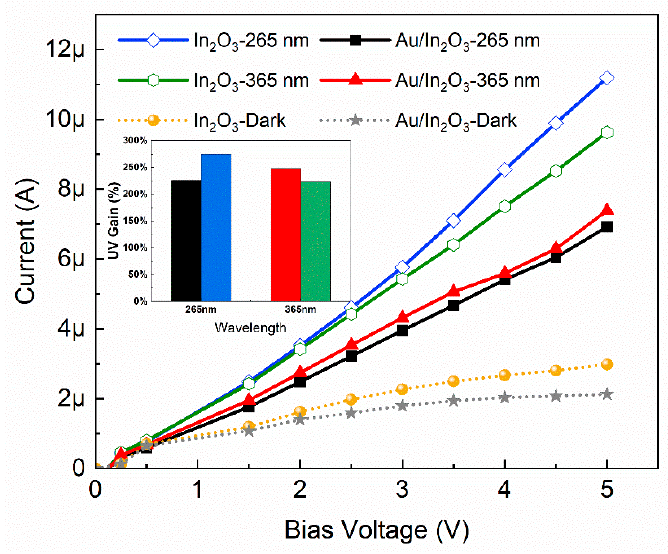
Figure 4. I–V Characteristics under UV illumination and dark condition; (inset) photoconductivity Gain at 265 nm and 365 nm.